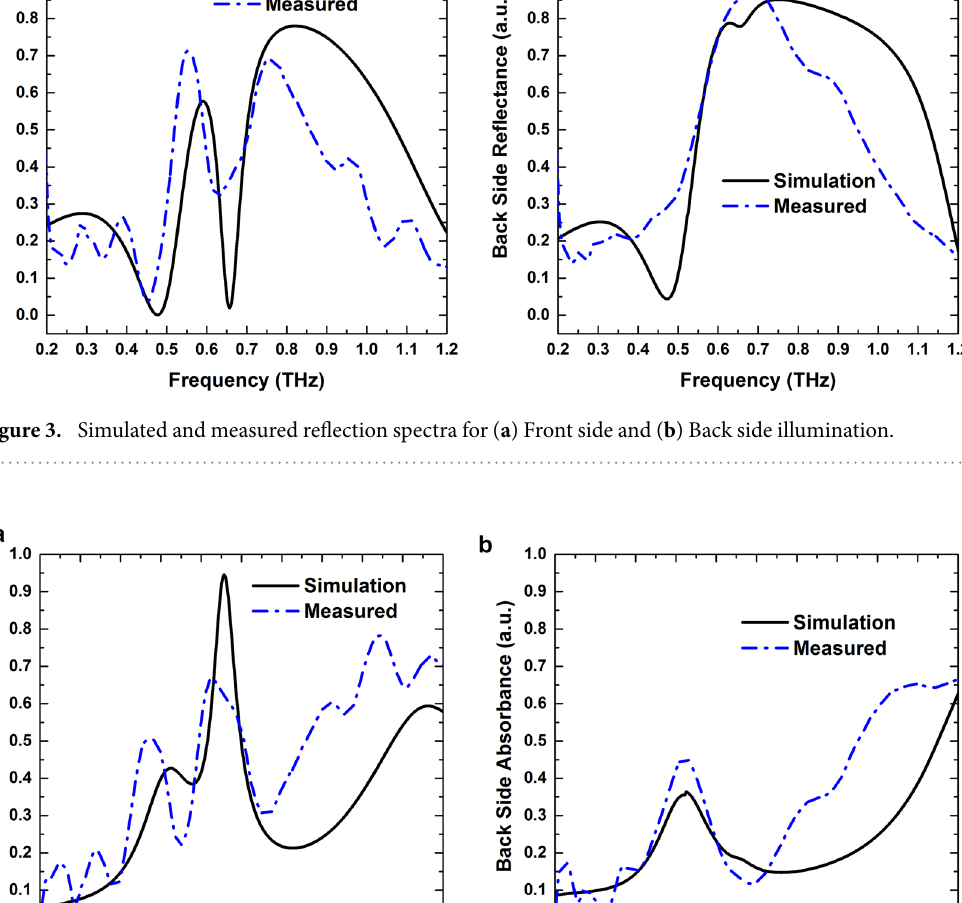
the numerical studies (shown in Fig. 1(a)). THz pulse impinging on the structure from director (reflector) side is indicated as front (back) side illumination. In our THz-Time Domain Spectroscopy (THz-TDS) measurements, we measured transmission and reflection for both front and backside illumination. All the simulated results with their corresponding experimental verifications are shown in Figs 2–4. Figure 2(a) and (b) show that the trans- mission spectra for both front and back side illumination are same. This indicates the transmittance through the structure is direction-independent of the incoming radiation. Figure 3(a) and (b) show that the front side reflection of the structure is different from the back side reflec- tion. This is due to the symmetry breaking of the structure in the line of wave propagation. The resonant dip at 0.657 THz in the front side reflectance is absent in case of the back side reflectance spectrum. Therefore, the Yagi-Uda array acts as a resonant absorber when THz wave is incident from director side of the structure. We calculate the absorbance spectra from = − + A T R 1 ( ) and plot in Fig. 4(a) and (b), respectively. The expected resonant peak in the front side absorbance spectrum is noticed at 0.657 THz where both the transmit- tance and reflectance are minimal. On the other hand, for back side illumination there is no significant absorb- ance peak as most of the field is reflected from the structure. The red shift of the measured absorption peaks with respect to the corresponding simulated peaks could be attributed to the slight mismatch in the material parame- ters and dimensions used in simulations and the actual. We plot power flow at the absorption peak (0.657 THz) for both front and back side illumination in Fig. 5. From the figure it is noticed that maximum power is absorbed near the feed and director when THz pulse is impinged on the structure from director side. Whereas, less power is absorbed when wave is coming from the reflector side. The angle dependent absorbance of the array at resonant absorption peak (0.657 THz) and two